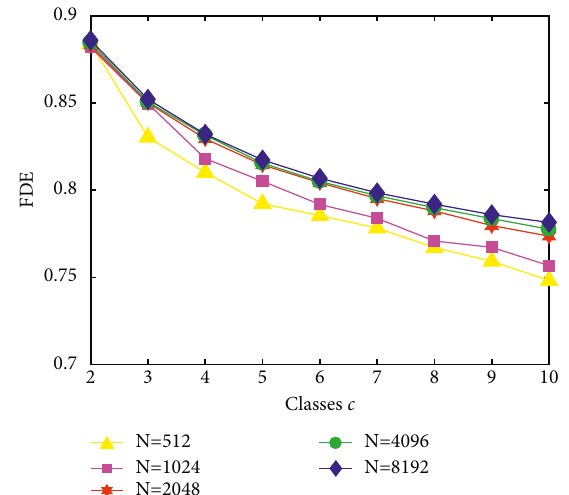
Figure 3: The FDE values of the signal under various data lengths.